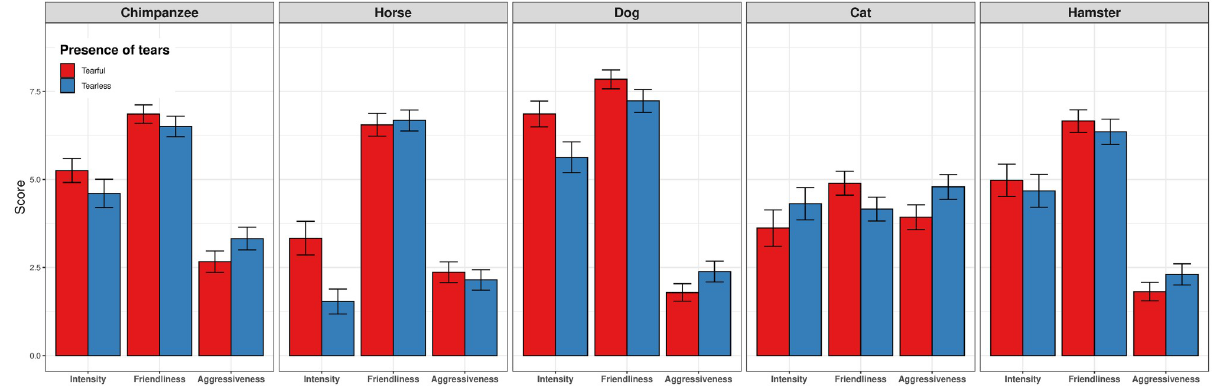
Fig 4. Bar plots per species and presence of tears.